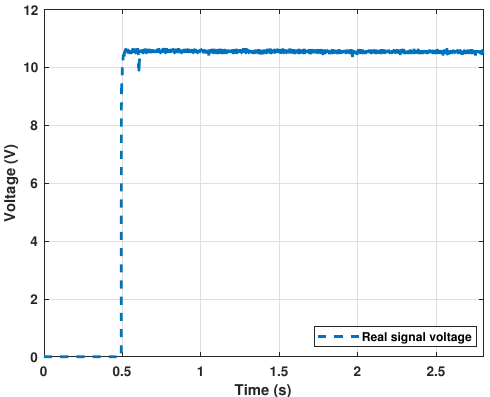
Figure 14. Step voltage signal used.